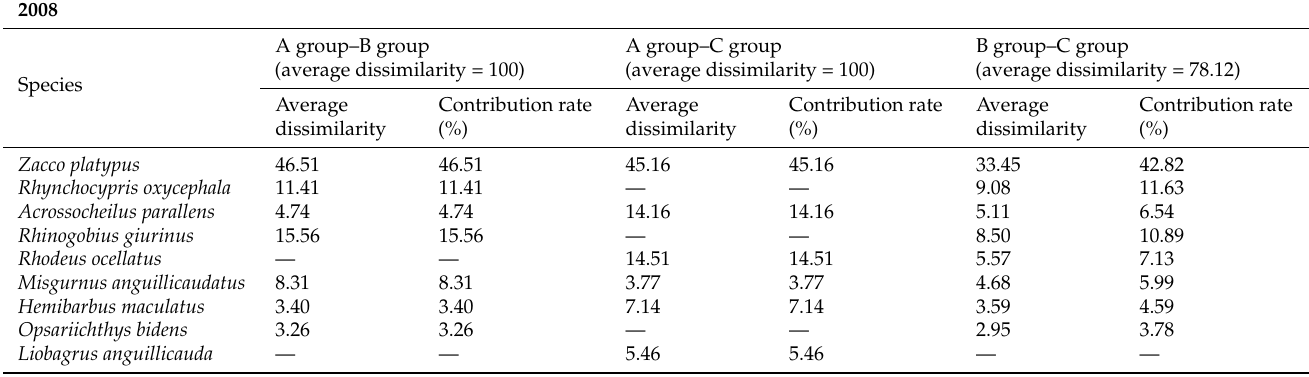
Figure 4. The Bray–Curtis resemblance matrix and the non-metric multidimensional scaling (NMDS) ordination for the community structure of fish in 2008 ( A , B ) and 2021 ( C , D ) in Lushan National Nature Reserve. River codes are the same as in Table 1. Table 2. Dissimilarity analysis (SIMPER) between fish assemblages in the Lushan National Nature Reserve in 2008 and